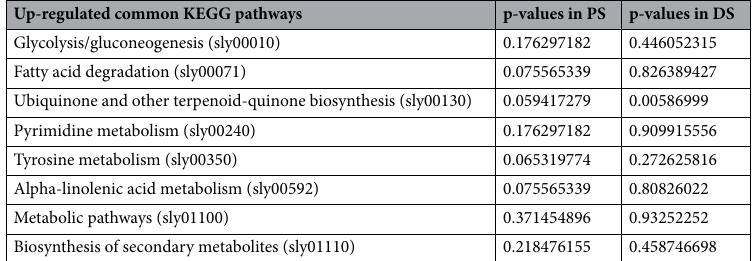
Table 1. Common pathways shared by PS and DS in KEGG enrichment analysis of up-regulated